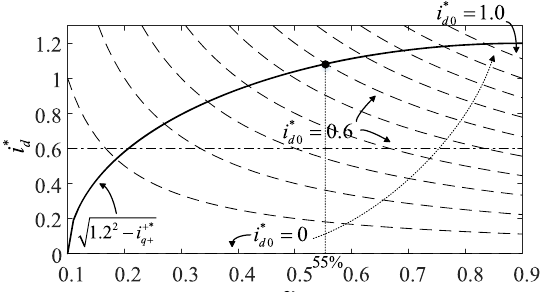
Fig. 8 Schematic diagram of active current compensation